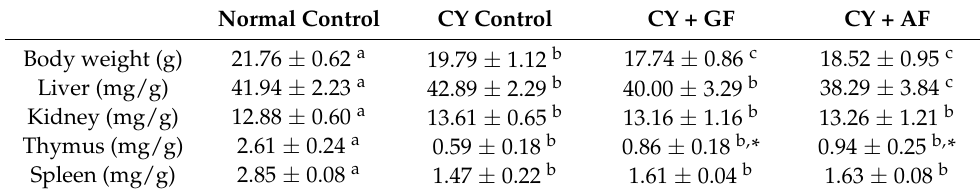
Table 2. Body weight and organ weight in male BALB/c mice.